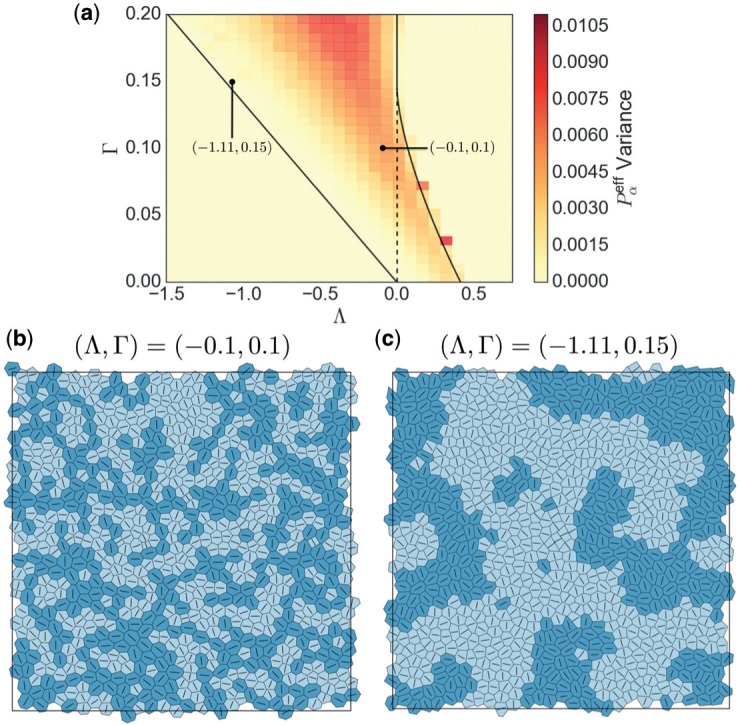
(a) A map of the variance of \documentclass[12pt]{minimal}
\usepackage{amsmath}
\usepackage{wasysym} 
\usepackage{amsfonts} 
\usepackage{amssymb} 
\usepackage{amsbsy}
\usepackage{upgreek}
\usepackage{mathrsfs}
\setlength{\oddsidemargin}{-69pt}
\begin{document}
}{}$P^{\text{eff}}_\alpha$\end{document} at discrete locations within region II of \documentclass[12pt]{minimal}
\usepackage{amsmath}
\usepackage{wasysym} 
\usepackage{amsfonts} 
\usepackage{amssymb} 
\usepackage{amsbsy}
\usepackage{upgreek}
\usepackage{mathrsfs}
\setlength{\oddsidemargin}{-69pt}
\begin{document}
}{}$(\Lambda,\Gamma)$\end{document}-parameter space. Lines show the boundaries for a hexagonal network, as in Fig. 4(a). The dark squares along the region II\documentclass[12pt]{minimal}
\usepackage{amsmath}
\usepackage{wasysym} 
\usepackage{amsfonts} 
\usepackage{amssymb} 
\usepackage{amsbsy}
\usepackage{upgreek}
\usepackage{mathrsfs}
\setlength{\oddsidemargin}{-69pt}
\begin{document}
}{}$_b$\end{document}/III boundary are artefacts, reflecting the co-existence of cells with small and large areas near this boundary. Each datapoint is taken from 5 realizations of a monolayer with 800 cells. (b) An individual monolayer realization for \documentclass[12pt]{minimal}
\usepackage{amsmath}
\usepackage{wasysym} 
\usepackage{amsfonts} 
\usepackage{amssymb} 
\usepackage{amsbsy}
\usepackage{upgreek}
\usepackage{mathrsfs}
\setlength{\oddsidemargin}{-69pt}
\begin{document}
}{}$\Lambda=-0.1$\end{document}, \documentclass[12pt]{minimal}
\usepackage{amsmath}
\usepackage{wasysym} 
\usepackage{amsfonts} 
\usepackage{amssymb} 
\usepackage{amsbsy}
\usepackage{upgreek}
\usepackage{mathrsfs}
\setlength{\oddsidemargin}{-69pt}
\begin{document}
}{}$\Gamma=0.1$\end{document}, \documentclass[12pt]{minimal}
\usepackage{amsmath}
\usepackage{wasysym} 
\usepackage{amsfonts} 
\usepackage{amssymb} 
\usepackage{amsbsy}
\usepackage{upgreek}
\usepackage{mathrsfs}
\setlength{\oddsidemargin}{-69pt}
\begin{document}
}{}$P_{\mathrm{ext}}=0$\end{document} with 800 cells. Darker (lighter) shading denotes cells with \documentclass[12pt]{minimal}
\usepackage{amsmath}
\usepackage{wasysym} 
\usepackage{amsfonts} 
\usepackage{amssymb} 
\usepackage{amsbsy}
\usepackage{upgreek}
\usepackage{mathrsfs}
\setlength{\oddsidemargin}{-69pt}
\begin{document}
}{}$P^{\text{eff}}>0$\end{document}\documentclass[12pt]{minimal}
\usepackage{amsmath}
\usepackage{wasysym} 
\usepackage{amsfonts} 
\usepackage{amssymb} 
\usepackage{amsbsy}
\usepackage{upgreek}
\usepackage{mathrsfs}
\setlength{\oddsidemargin}{-69pt}
\begin{document}
}{}$(<0)$\end{document}. Line segments indicate the principal axis of the shape and stress tensor for each cell, coincident with the heavy arrows in Fig. 4(b), i.e. aligned with the stress eigenvector associated with the eigenvalue of larger magnitude. (c) A similar example for \documentclass[12pt]{minimal}
\usepackage{amsmath}
\usepackage{wasysym} 
\usepackage{amsfonts} 
\usepackage{amssymb} 
\usepackage{amsbsy}
\usepackage{upgreek}
\usepackage{mathrsfs}
\setlength{\oddsidemargin}{-69pt}
\begin{document}
}{}$\Lambda=-1.11$\end{document}, \documentclass[12pt]{minimal}
\usepackage{amsmath}
\usepackage{wasysym} 
\usepackage{amsfonts} 
\usepackage{amssymb} 
\usepackage{amsbsy}
\usepackage{upgreek}
\usepackage{mathrsfs}
\setlength{\oddsidemargin}{-69pt}
\begin{document}
}{}$\Gamma=0.15$\end{document}. (Colour in online.)